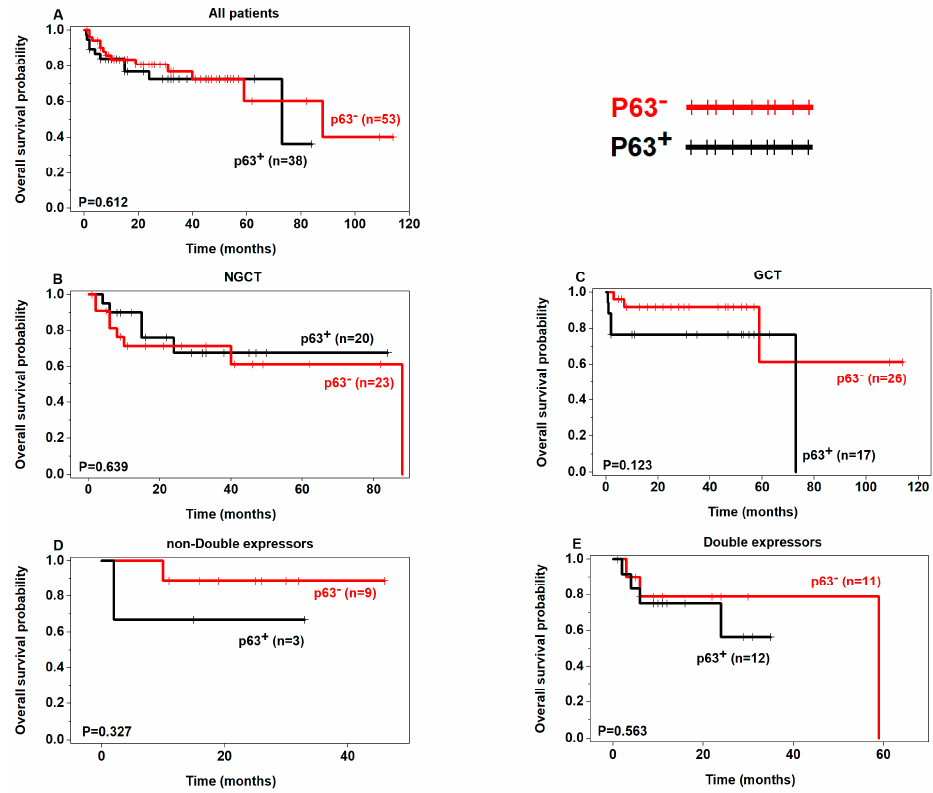
Curr. Oncol. 2023 , 30